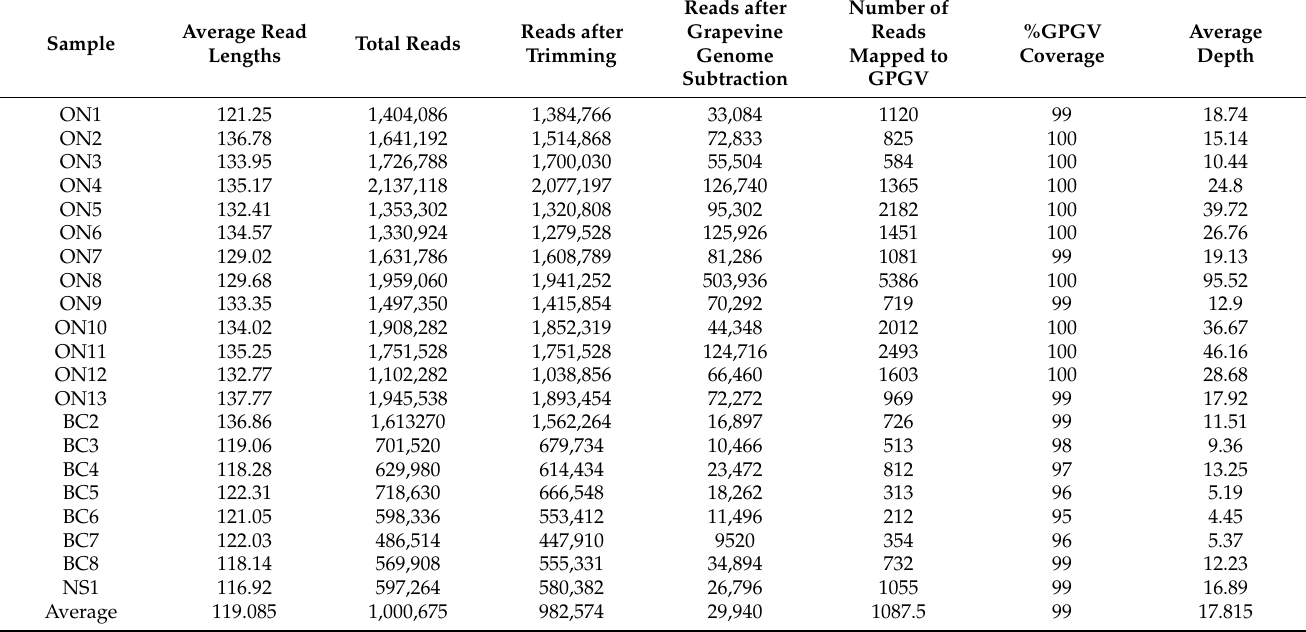
Table 3. Sequencing statistic of grapevine Pinot gris virus isolates in this